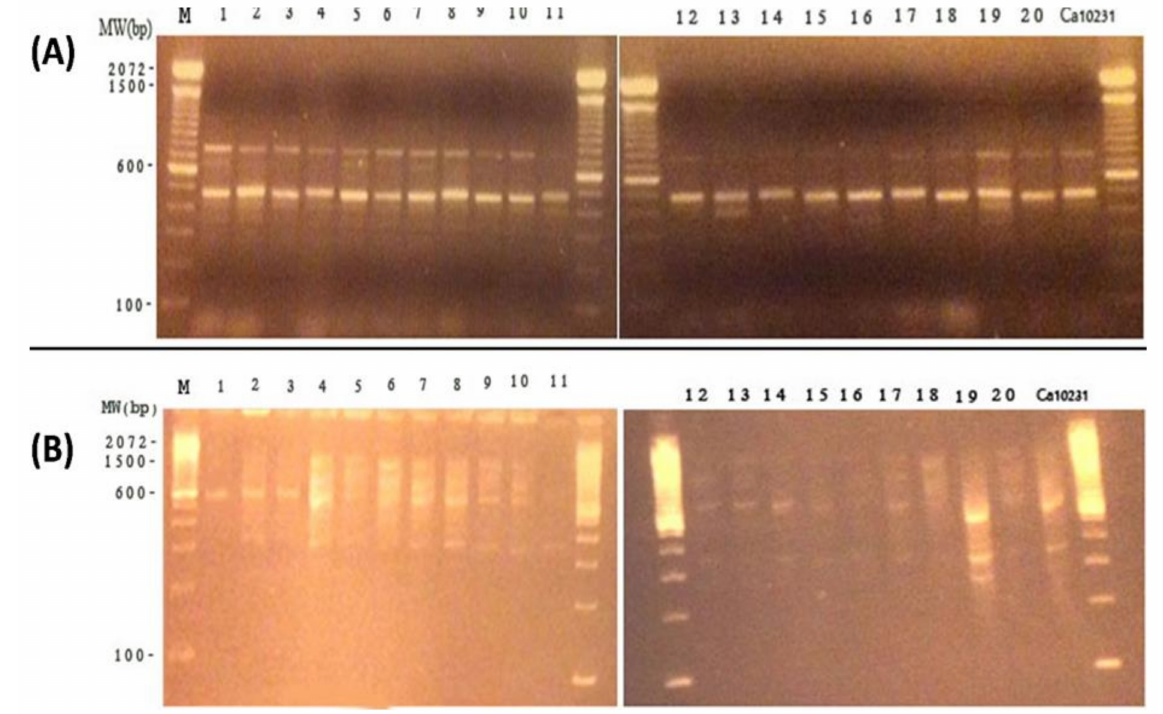
Figure 3. RAPD-PCR patterns generated by C. albicans isolates using ( A ) OPG 13 primer, ( B ) RSD 11 primer. Numbered lanes show patterns of the 20 C. albicans isolates. Ca10231: C. albicans 102311. M:100 bp PCR DNA marker.